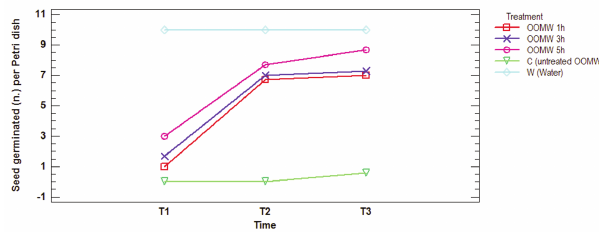
Fig. 2 - Interaction plot (treatment x time) from multiway